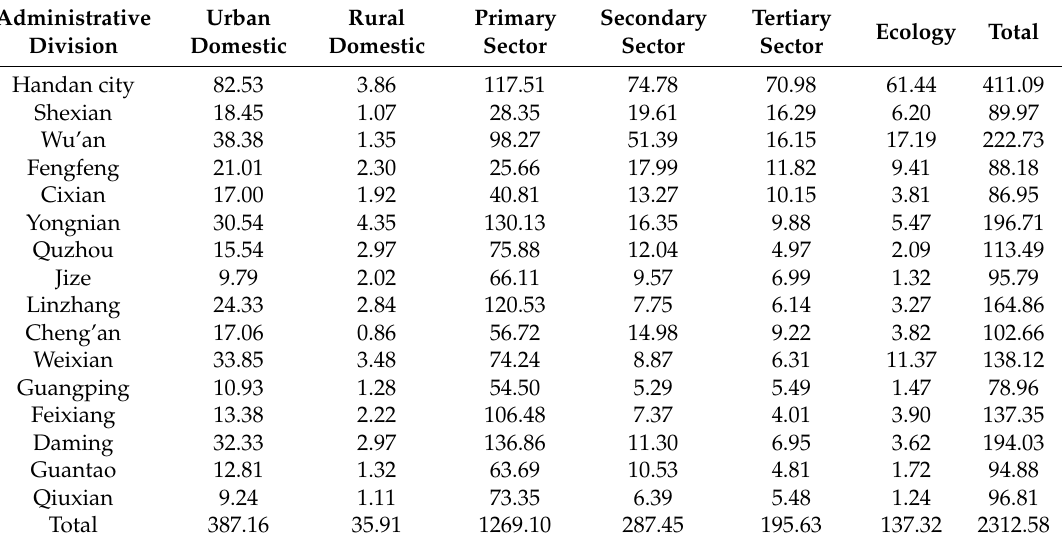
Table 15. Results for water allocation of WOA (10 6 m 3 ).